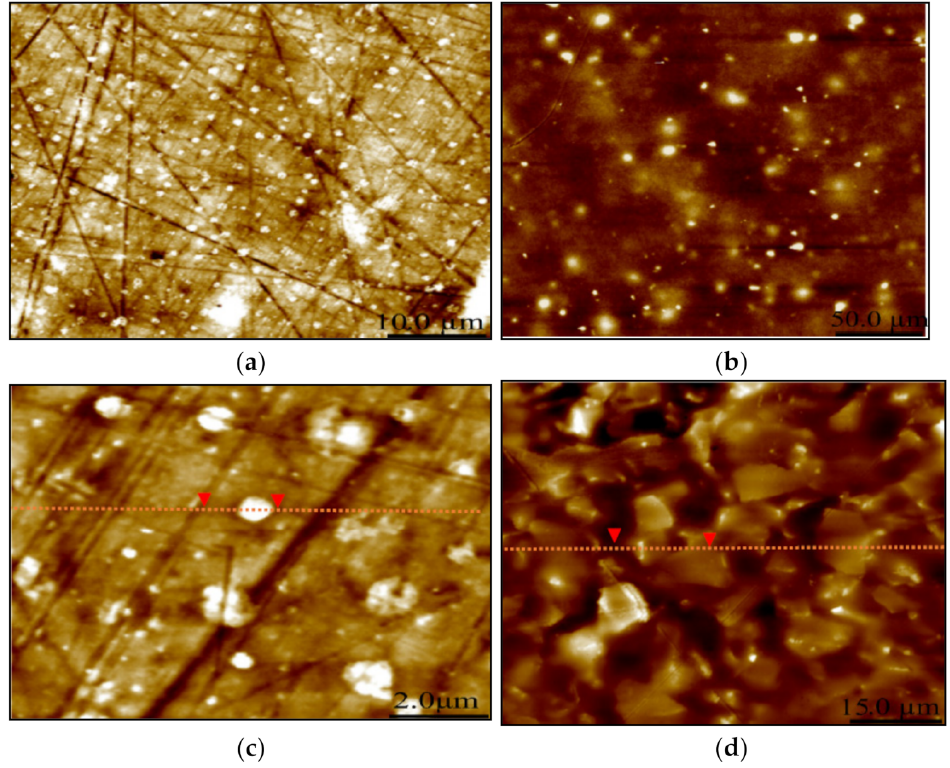
Figure 21. Atomic force microscope images of ( a , c ) NBCs and ( b , d ) MBCs at different magnifica- tions